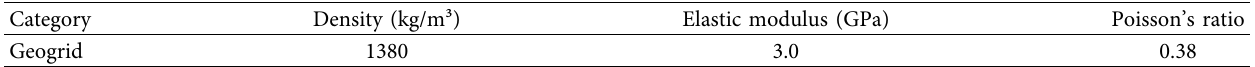
Table 3: Mechanical properties of geogrids.